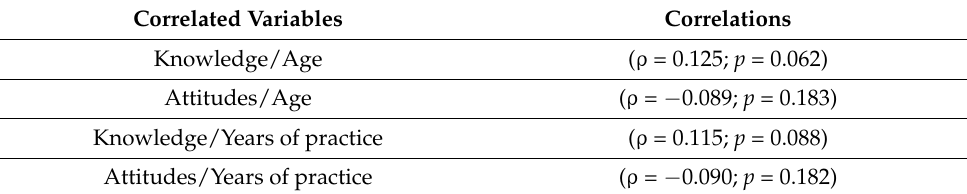
Table 4. Correlations between variables.